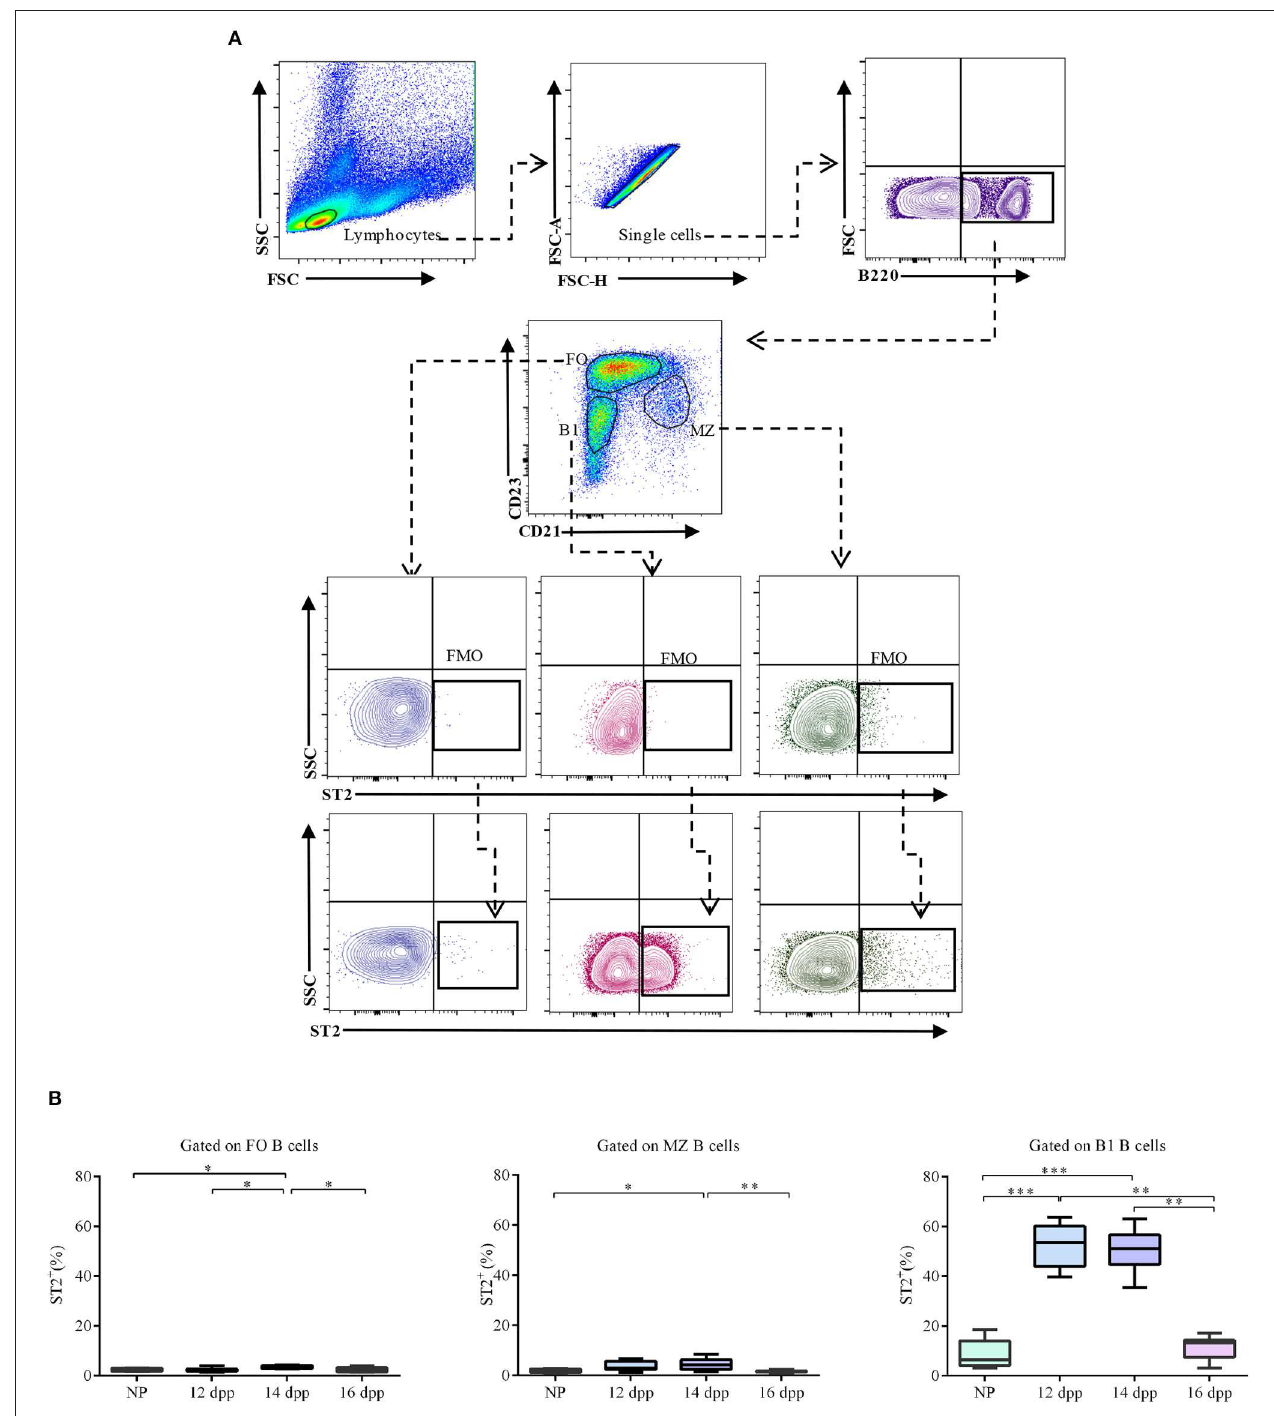
FIGURE 3 | Percentages of ST2-expressing follicular, marginal zone, and B1 B cells in the spleen of pregnant and non-pregnant mice. (A) Representative pseudocolor and contour plots showing gating strategy used to quantify percentages of ST2-expressing follicular (FO), marginal zone (MZ), and B1 B cells in the spleen of pregnant and non-pregnant females. Lymphocytes were gated by FSC vs. SCC, doublets were eliminated, and B220 was used to define total B cells. CD23 and CD21 markers were used to identify FO (B220 + CD23 hi CD21 low ), MZ (B220 + CD23 low CD21 hi ), and B1 (B220 low CD23 − CD21 − ) B cells. Fluorescence minus one (FMO) was used as control. (B) Box and Whisker plots showing percentages of ST2-expressing FO, MZ and B1 B cells at day 12 (12 dpp; n = 9, n = 9, and n = 9, respectively), 14 (14dpp; n = 11, n = 11, and n = 11, respectively) and 16 (16 dpp; n = 7, n = 7, and n = 7, respectively) of pregnancy as well as in non-pregnant females (NP; n = 11, n = 11, and n = 11, respectively). Data are expressed as box and whisker plots showing median. * p < 0.05; ** p < 0.01; *** p < 0.0001 as analyzed by ANOVA followed by Tukey’s multiple comparisons test.